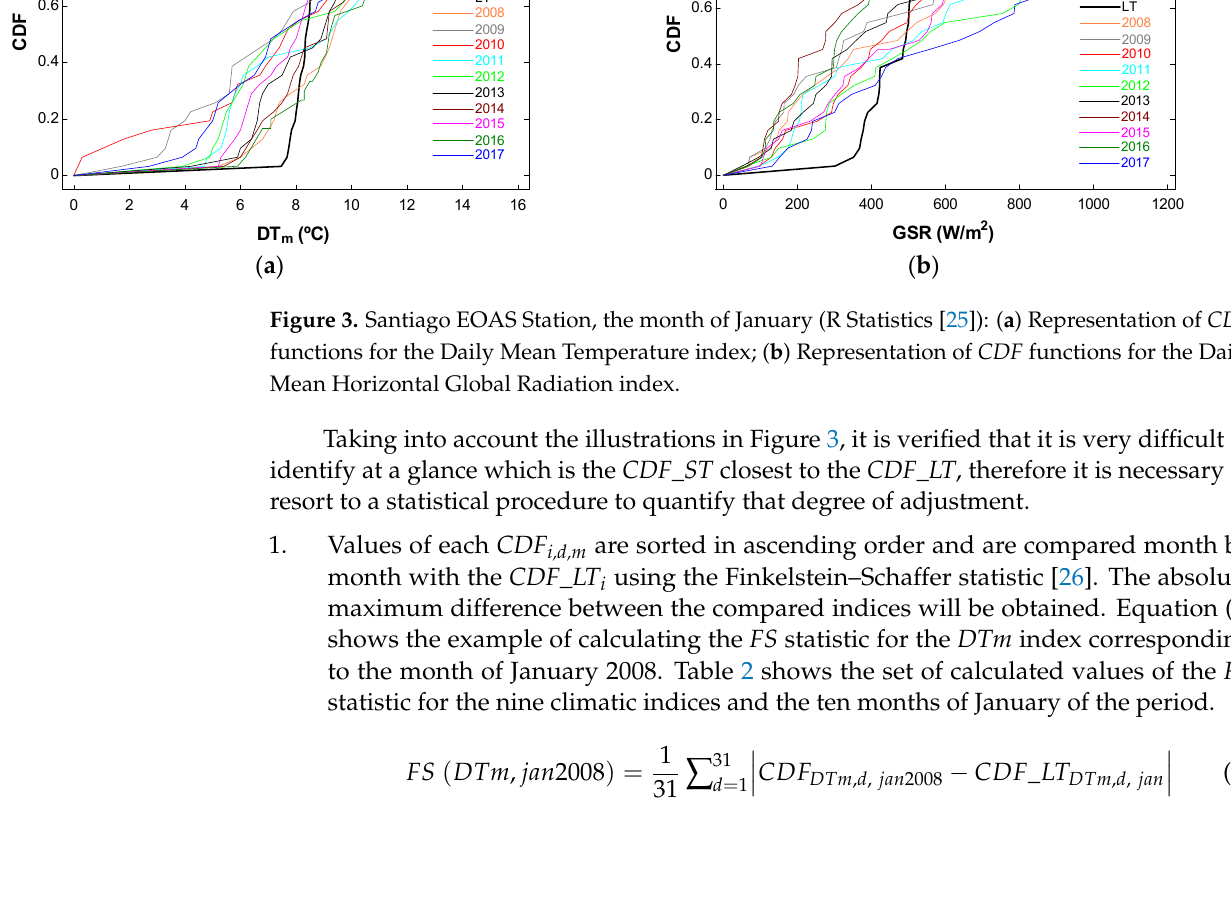
Table 2. FS values for climatic indices obtained from the Santiago EOAS station (months of January, 2008–2017).